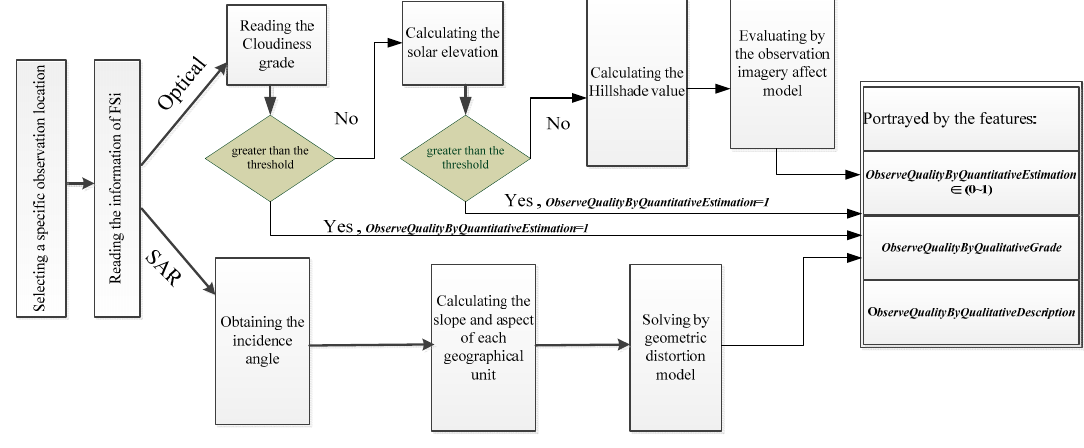
Figure 6. Workflow of the GEOCF composition operation.